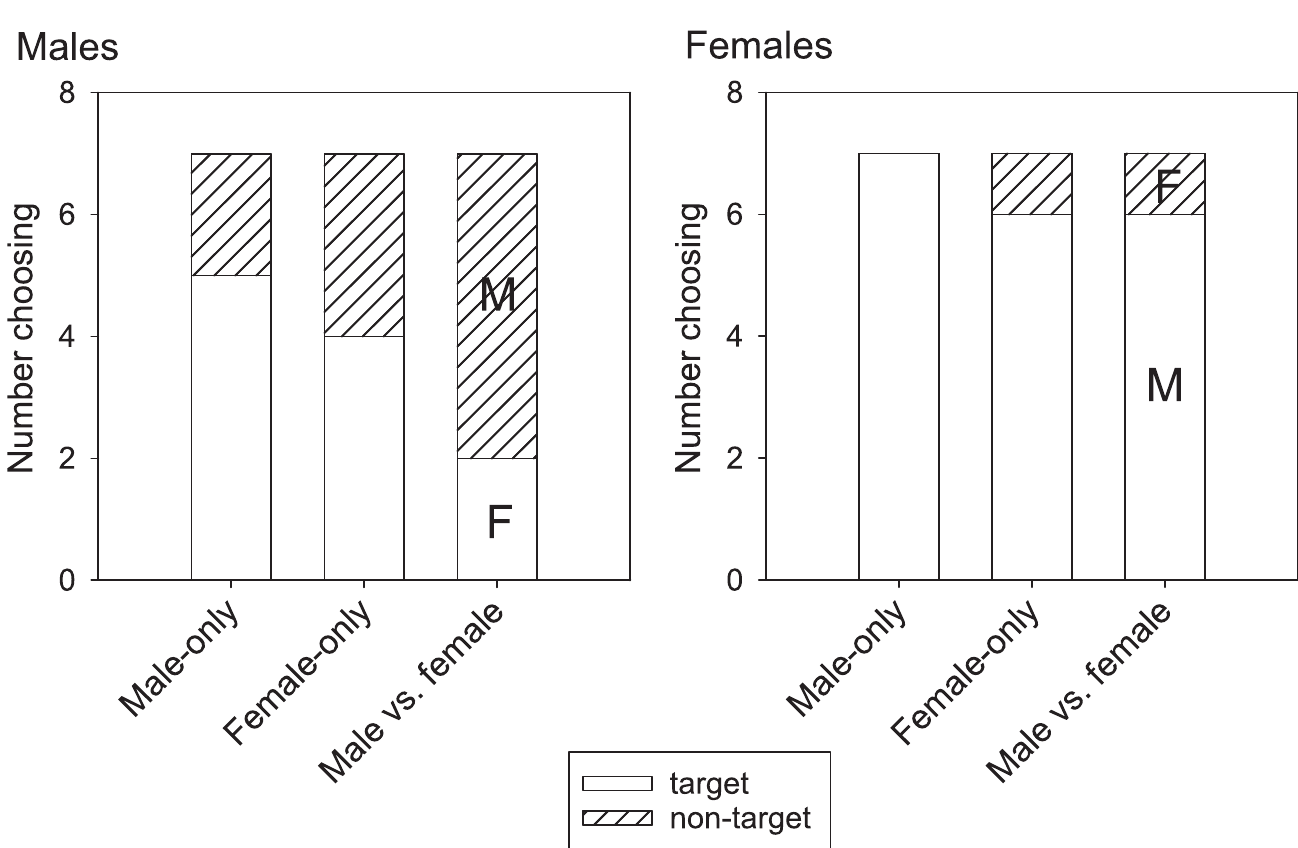
Fig 1. Choice results from Y-maze trials. In spring, females (left; n = 7) had a stronger preference for conspecific scent than did males (right; n = 7), especially when both male and female scent trails were present in the Y-maze. The only statistically significant choice was in the Male-only scent trials for females where 7/7 female tegus chose the male arm of the maze. The binomial probability for 6/7 successful choices is P = 0.054. In fall trials, male tegu performance in the Y-maze trials was similar to spring.